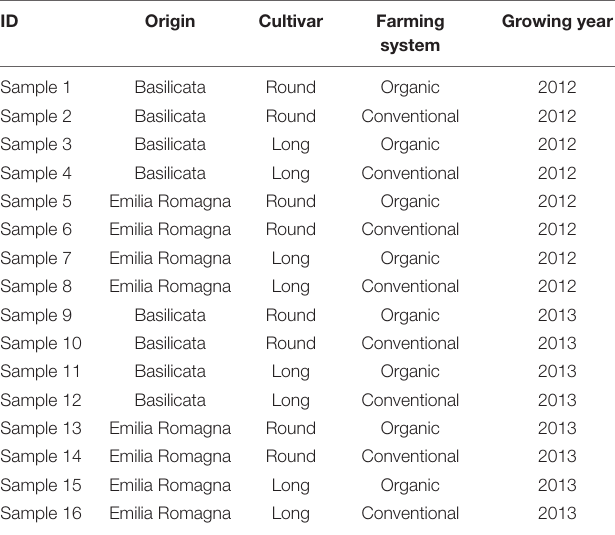
TABLE 1 | List of the different tomato samples under